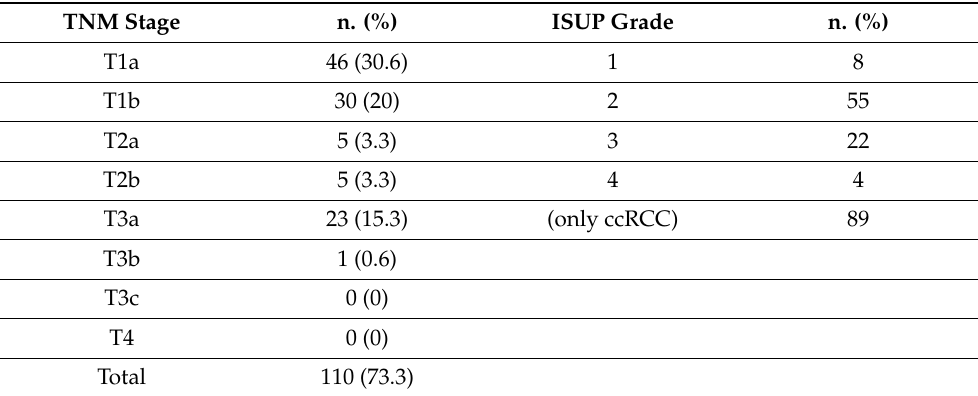
Table 2. Pathological Renal Tumour